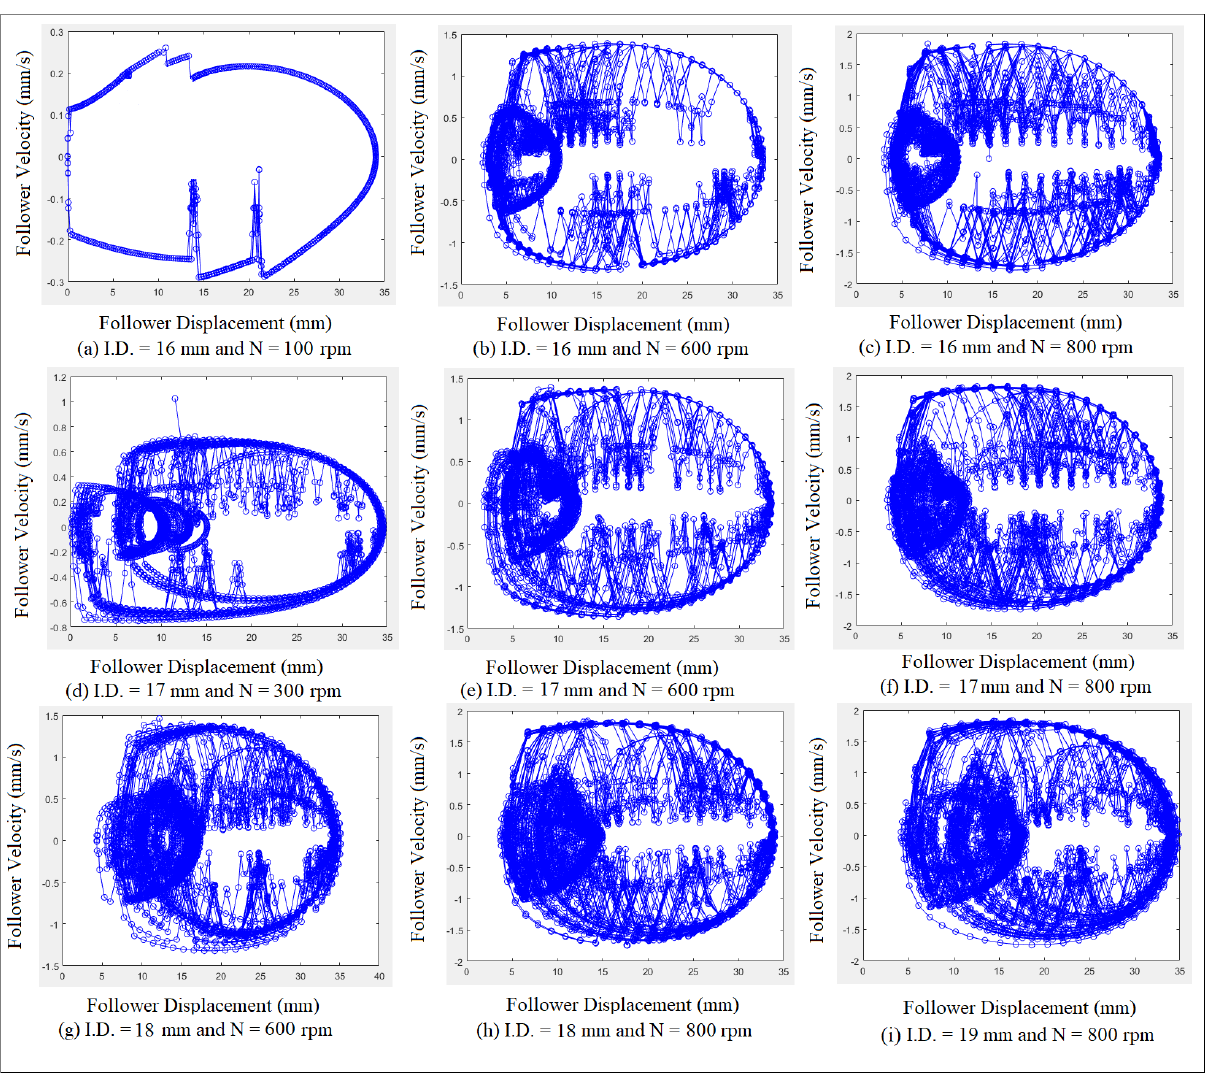
Figure 31. Phase-plane mapping for cam profile no.(3) at different (I.D.) and different (N).